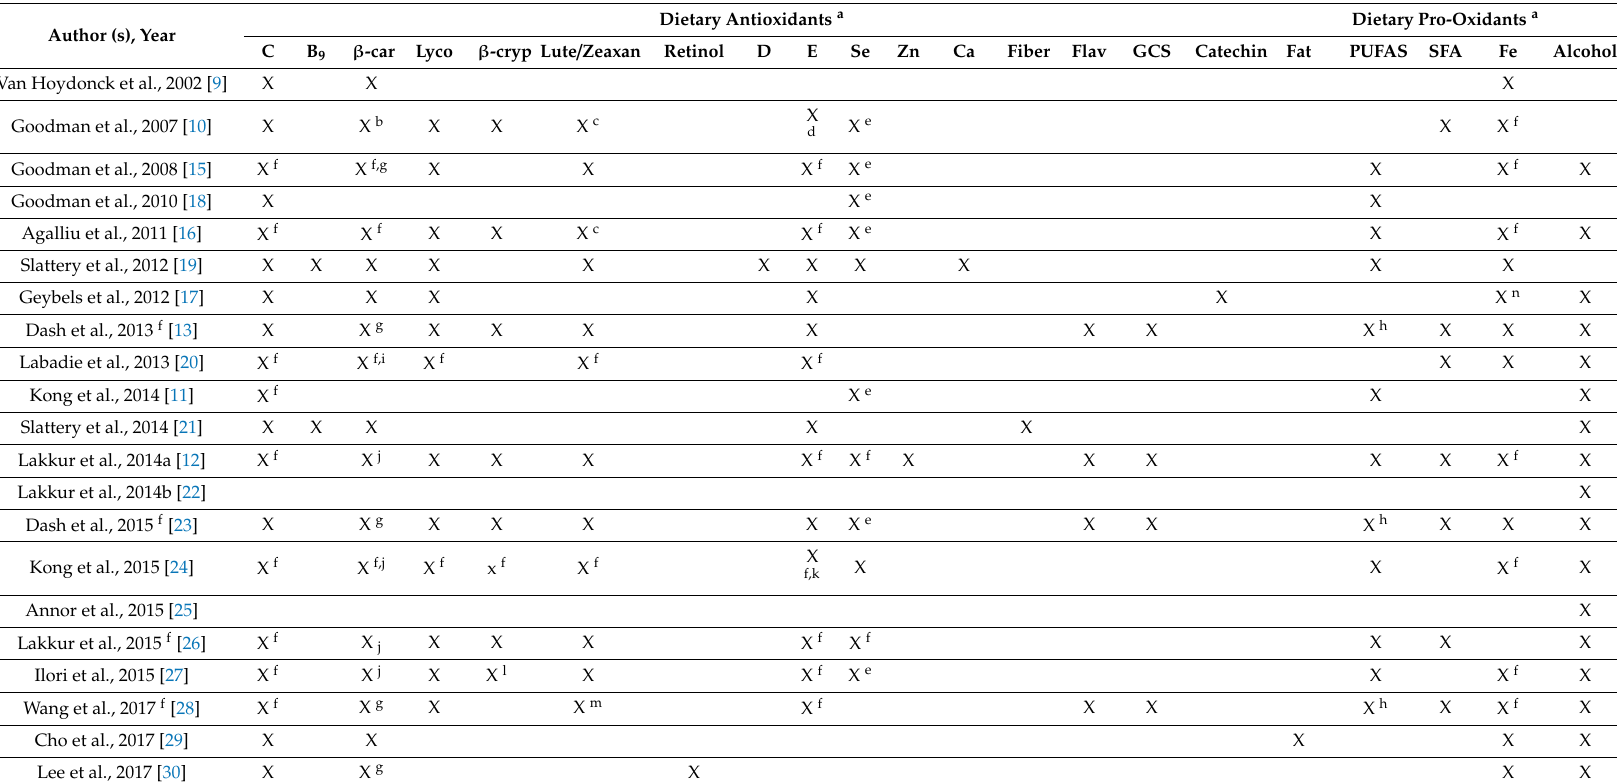
Table 3. Dietary components included in each a priori Oxidative Balance